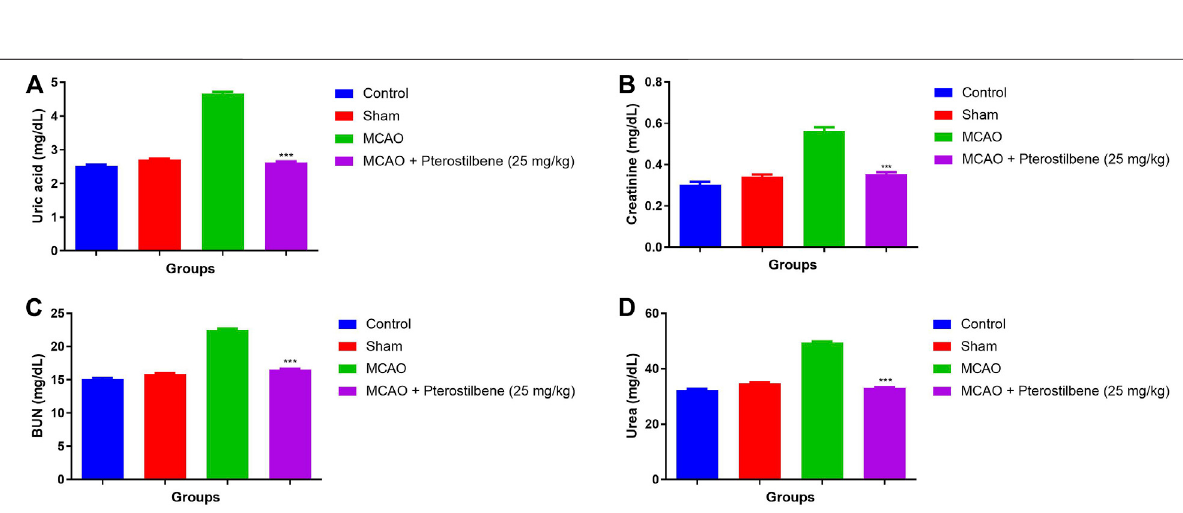
Frontiers in Pharmacology |